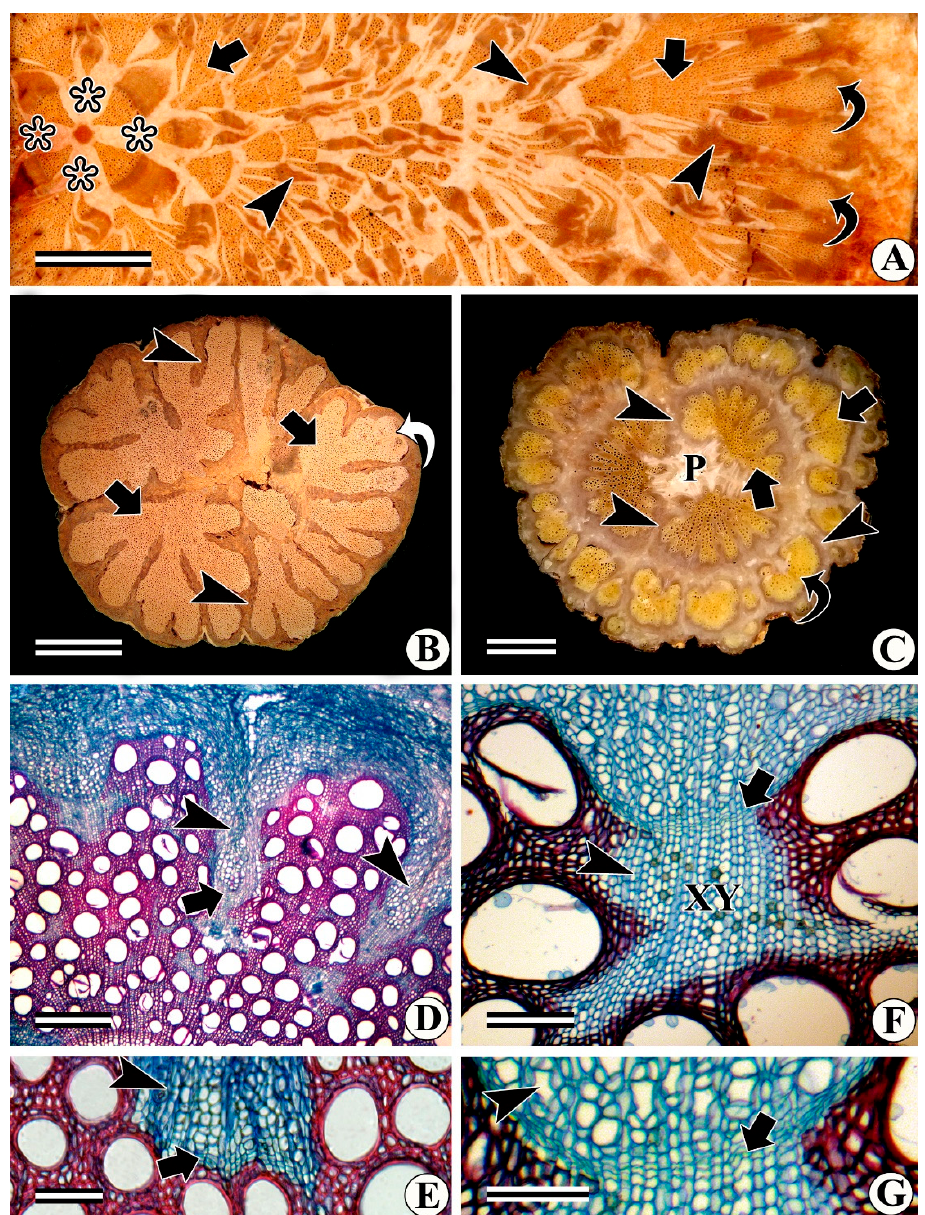
Figure 17. Macro-morphology of thick stems ( A – C ) and transverse view of the stem ( D – G ) showing phloem wedges in different eudicots. ( A ) Macroscopic view of Dolichandra unguis-cati showing the structure of the secondary xylem. Note the initial four wedges (asterisks), xylem formed in interwedges (arrows), phloem (arrowheads), and interwedges (curved arrows). ( B , C ) Mature stem of Heteropterys sp. ( B ) and Hewittia malabarica ( C ) showing phloem wedges (arrowheads), xylem formed by the cambium of interwedges (arrows), and interwedges (curved arrow). ( D ) Phloem wedges in Jacquemontia pentanthos showing phloem wedges (arrowheads). Note the position of the cambium (arrow). ( E ) Enlarged view of Figure 17D showing phloem wedge (arrowhead) and position of the cambium (arrow). ( F ) Phloem wedges in Merremia vitaefolia showing phloem wedges (arrowhead). Note the position of the cambium (arrow). ( G ) Enlarged view of Figure 17F showing phloem wedge (arrowhead) and position of the cambium (arrow). Abbreviations : P = pith, XY = xylem. Scale bars : ( A ) = 7 mm; ( B , C ) = 8 mm; ( D ) = 500 µ m; ( F ) = 200 µ m; ( E , G ) = 100 µ